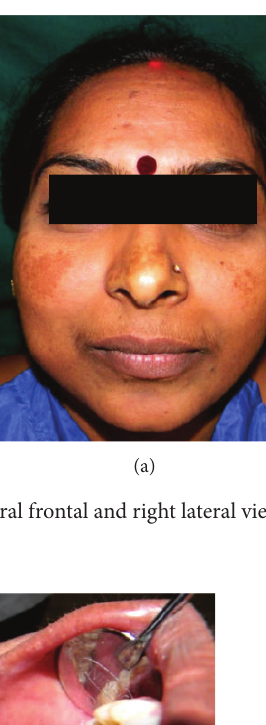
superimposed over the right mandibular third molar region (Figures 3, 4, and